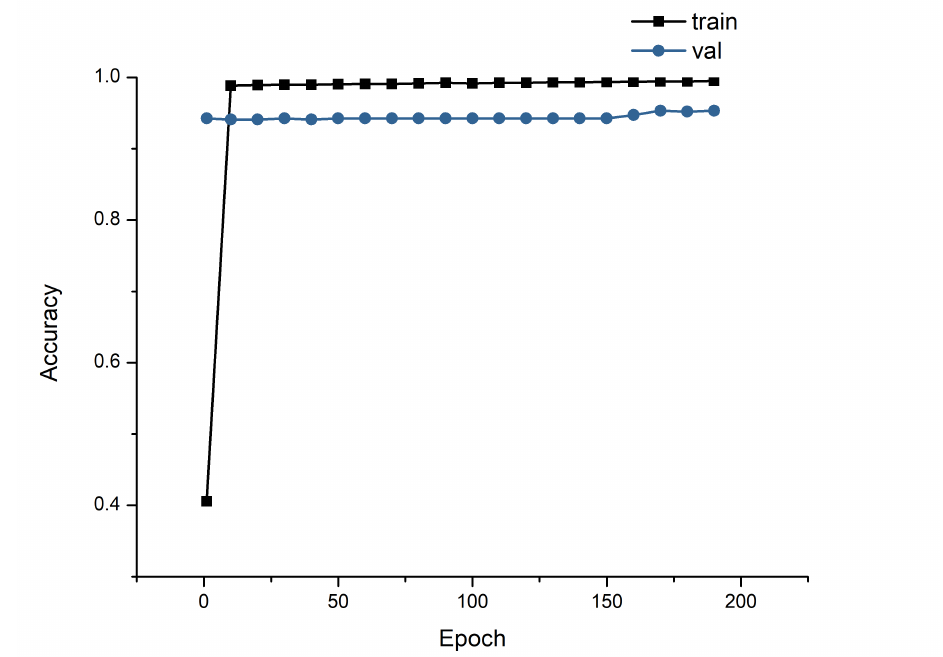
Figure 4. Classification accuracy of Cert GCN model on the training set and validation set of certificates.